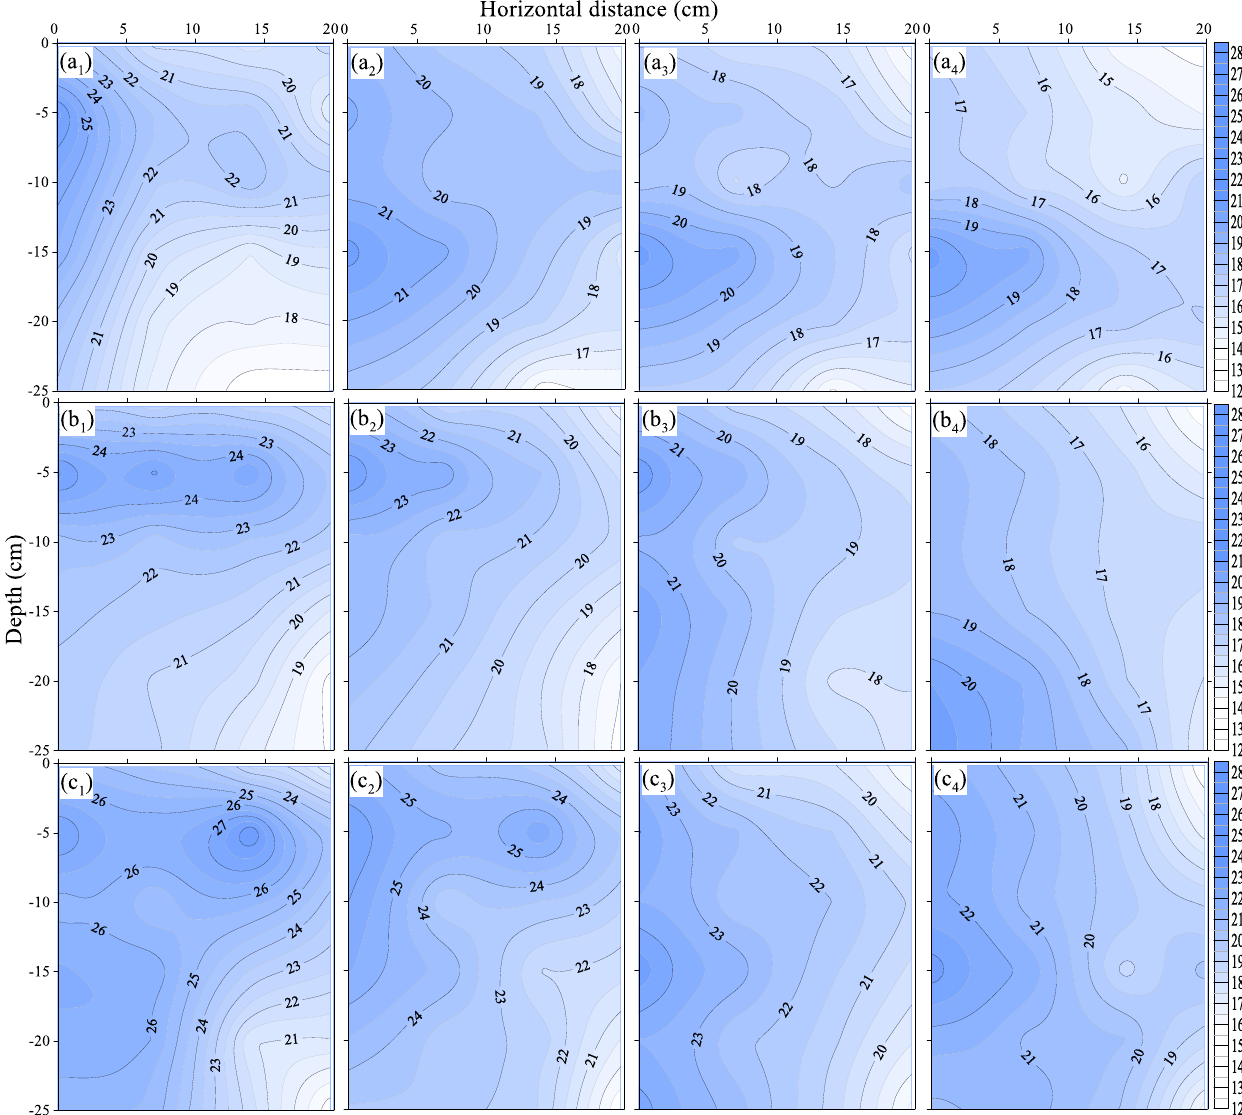
Figure 3. Soil moisture distribution under SDI 5 + N 300 treatment. Latter a, b, and c represent first, second, and third irrigation events. The subscript numbers 1–4 denote sampling times of soil moisture subsequent to each irrigation.